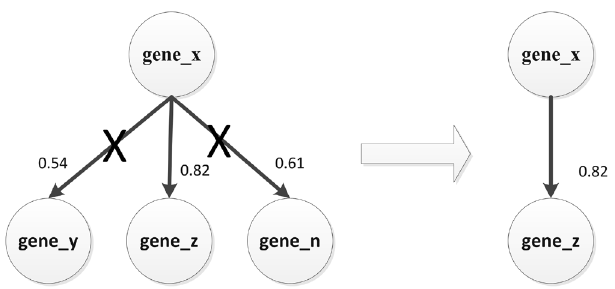
Figure 13. Screen the strongest gene regulatory relationship.